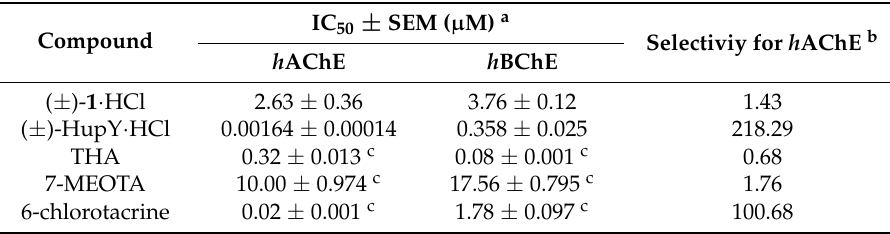
Table 1. Inhibitory activities of novel ( ± )- 1 · HCl and reference compounds (( ± )-HupY · HCl, THA, 7-MEOTA and 6-chlorotacrine) for h AChE and h BChE expressed as IC 50 values.